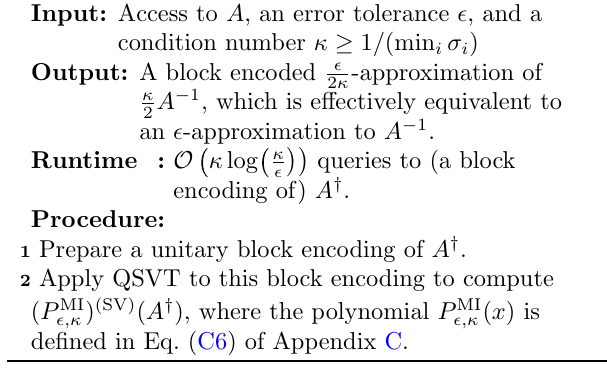
Algorithm 5. Matrix Inversion by